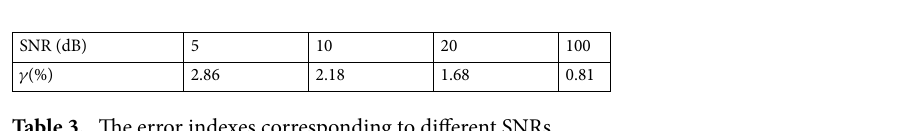
Table 3. The error indexes corresponding to different